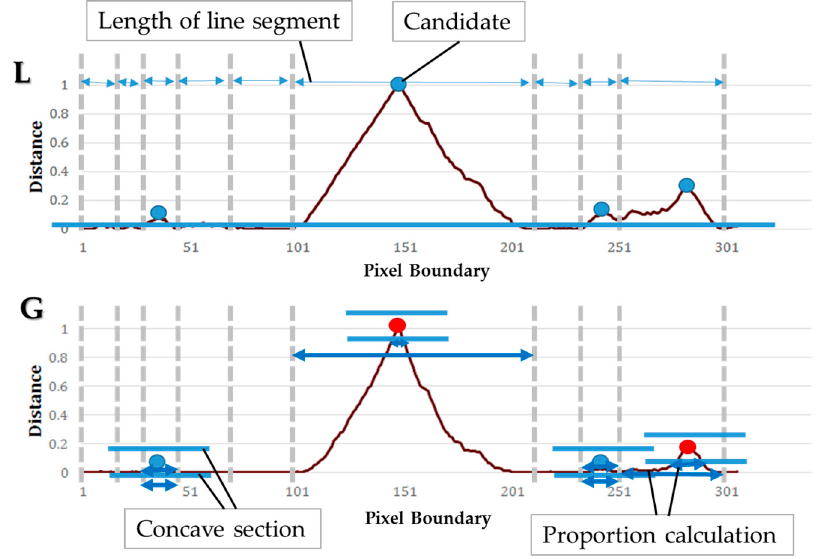
Figure 13. Generation of concave points (CPs) with two different types of time-series data.